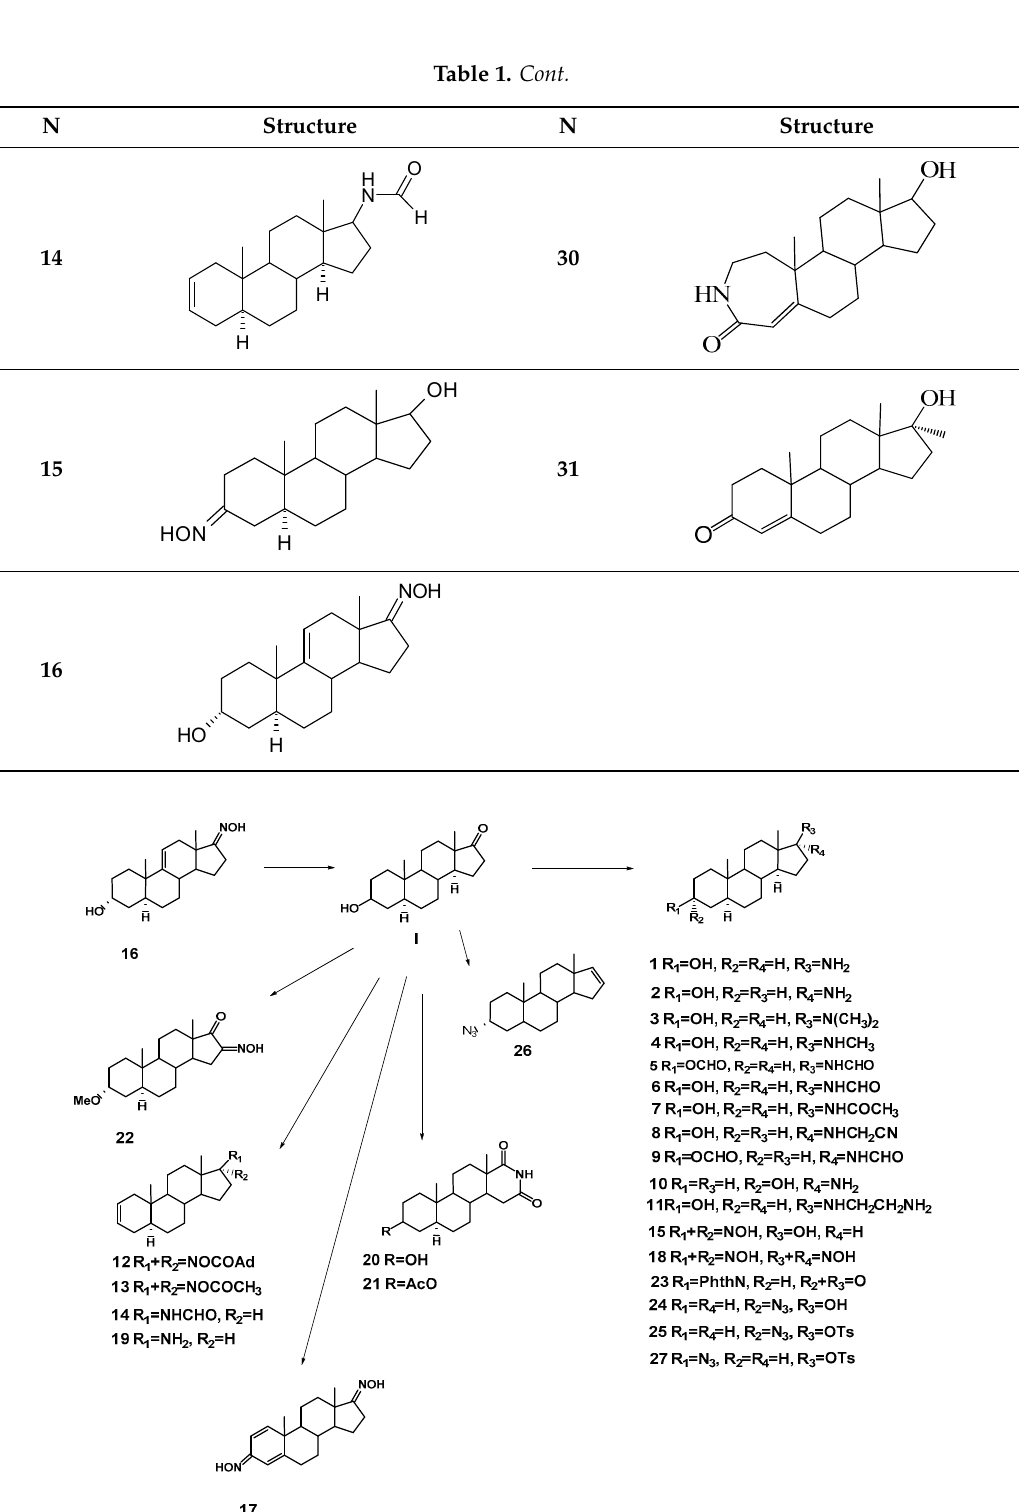
Table 2. Predicted biological activity spectra for the studied molecules. N